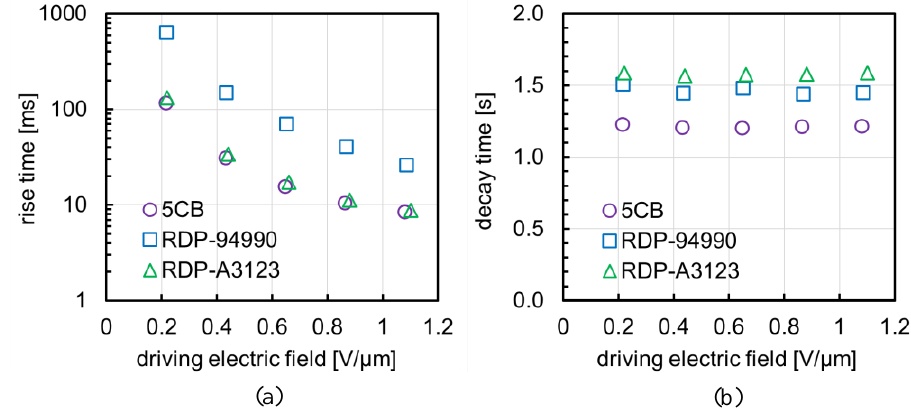
Figure 9. Electric field dependencies of ( a ) rise time and ( b ) decay time of 5CB, RDP-A3123, and RDP-94990.